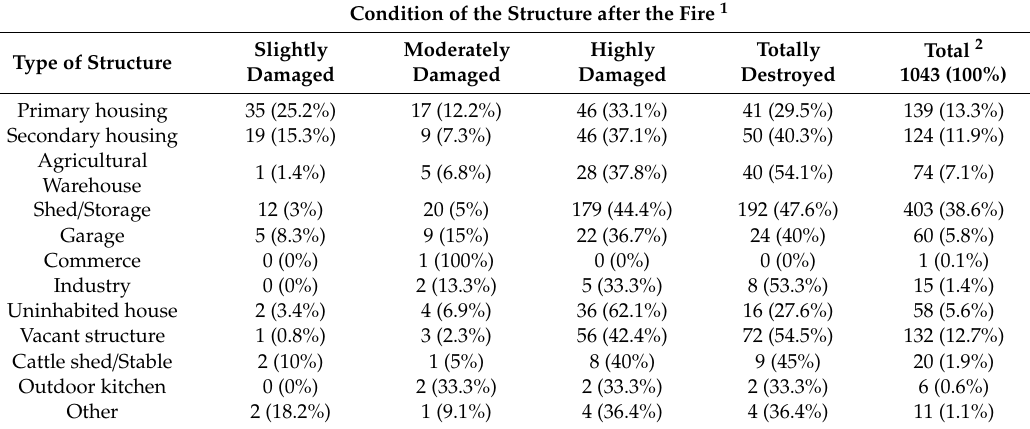
Table 4. Degree of damage according to the type of